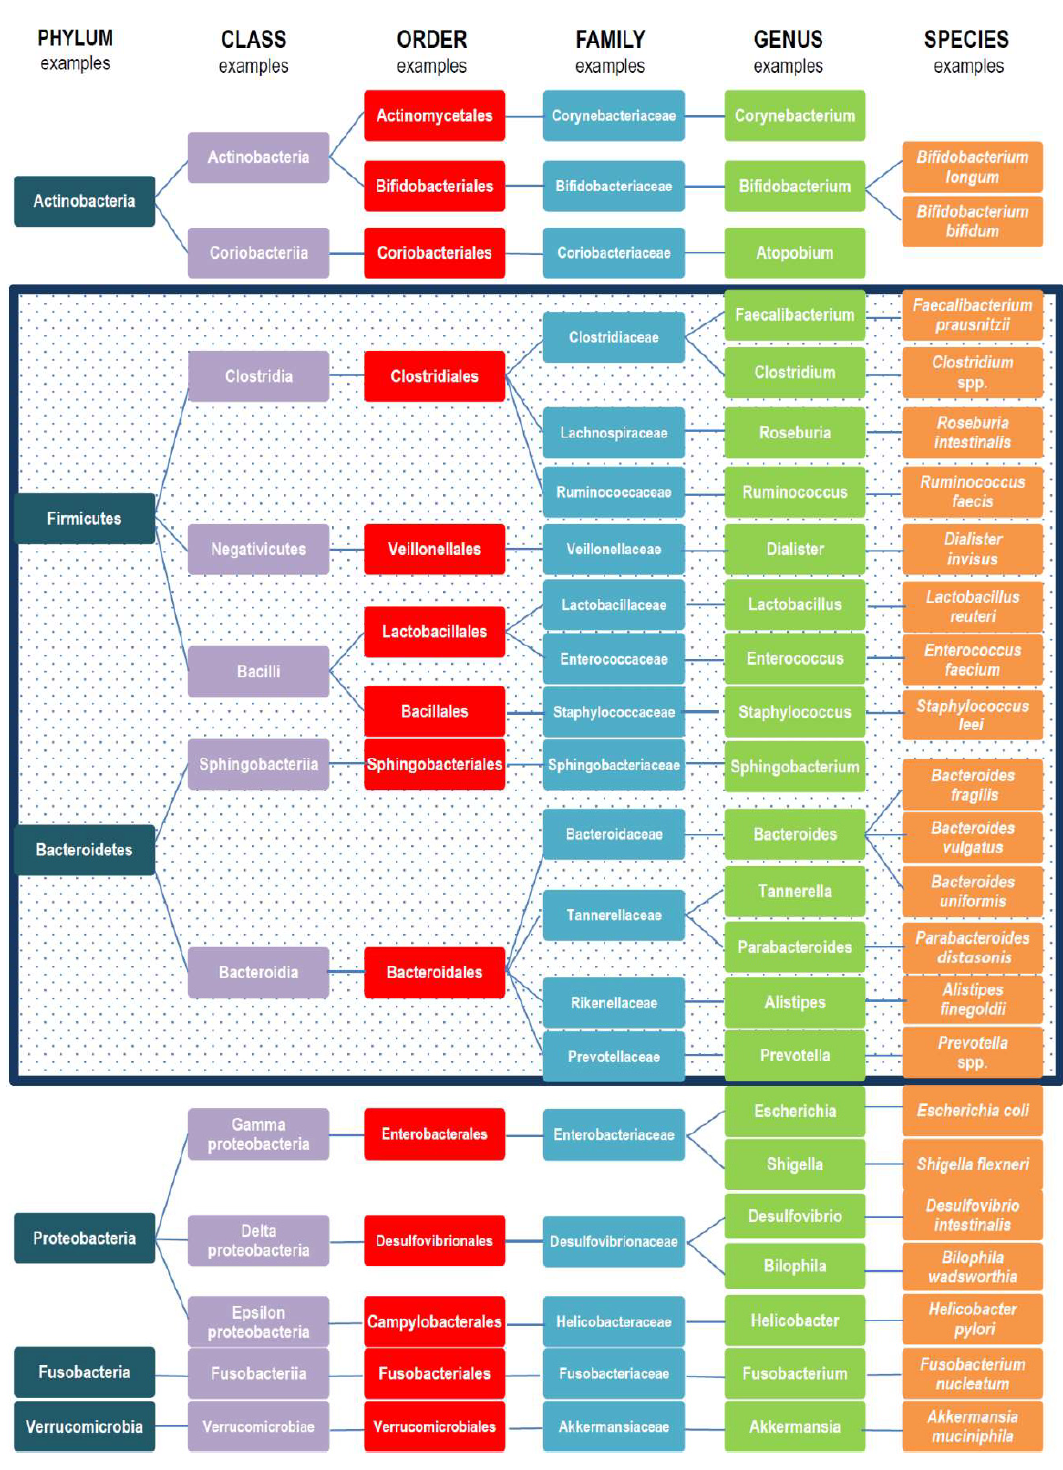
Figure 1. Examples of taxonomic gut microbiota composition. In the box are cited examples of bacteria belonging to Phyla Firmicutes and Bacteroidetes, representing 90% of gut microbiota. Reprinted from Rinninella E, Raoul P, Cintoni M, Franceschi F, Miggiano GAD, Gasbarrini A, Mele MC. Microorganisms 2019, 7(1), 14. Copyright 2019 by the authors; licensee is MDPI, Basel, Switzerland; reprinted with permission under an open access Creative Commons Attribution (CC BY) license (http://creativecommons.org/licenses/by/4.0/, accessed on 20 December 2022). See: https://doi.org/10.3390/microorganisms7010014, accessed on 20 December 2022).